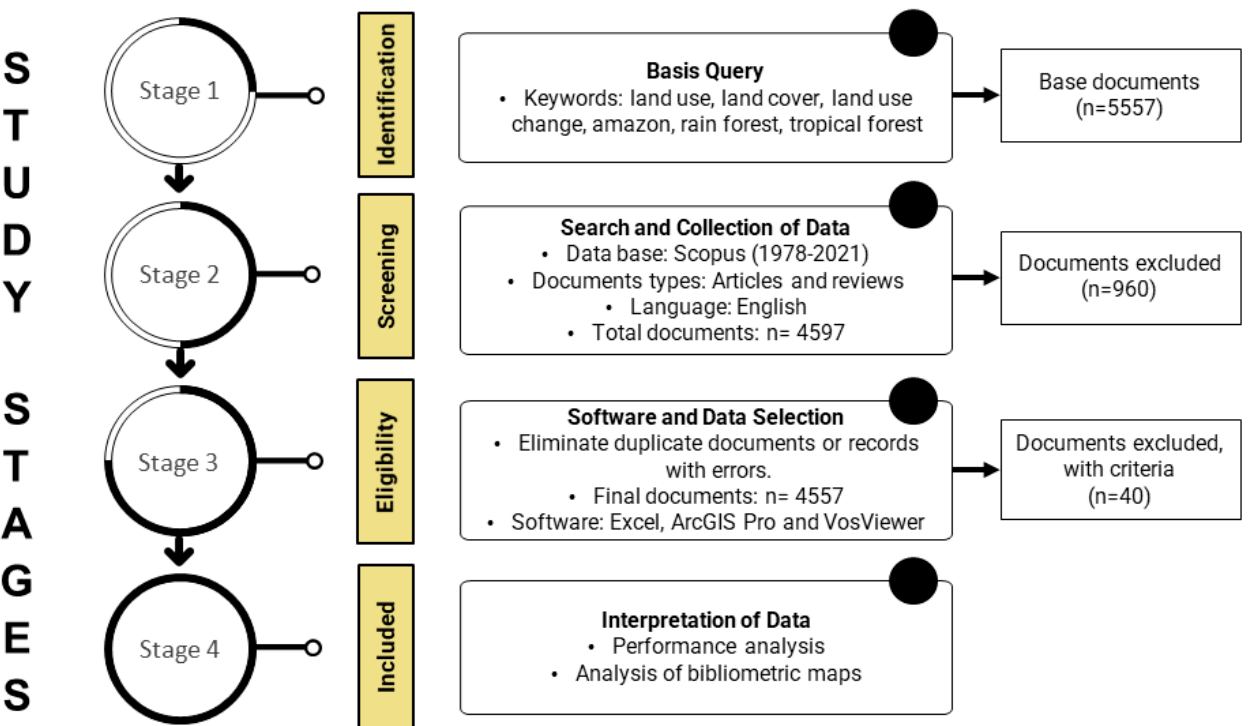
Figure 1. Diagram inspired by the PRISMA statement detailing the four phases of the bibliometric research methodology.